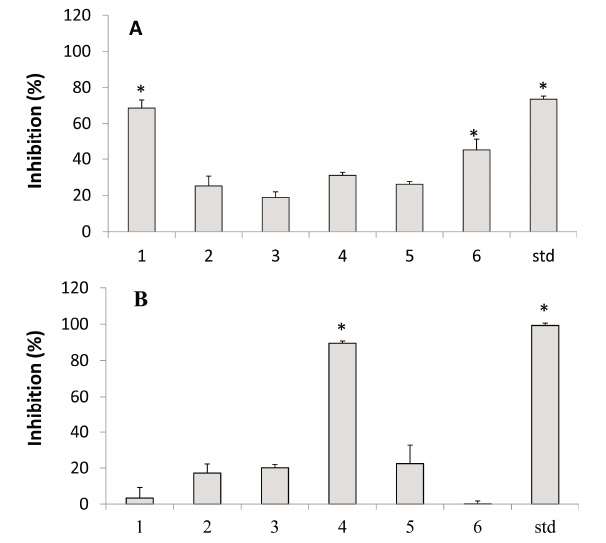
Figure 1. Tyrosinase and lipoxygenase activities of the isolated diterpenes from Copaifera sp. ( A ) Tyrosinase—Samples at 250 µM, and Kojic acid as standard (std); ( B ) Lipoxygenase— Samples at 200 µM, and quercertin as standard (std). 1. 3-hydroxy-copalic acid, 2. kaurenoic acid, 3. 3-acetoxy-copalic acid, 4. kolavic acid15-methyl ester, 5. copalic acid, and 6. hardwickiic acid. Each value is the mean ± S.E. of three independent experiments. Statistical analysis was performed using Holm-Sidak multiple comparisons. * p < 0.05 compared with the negative